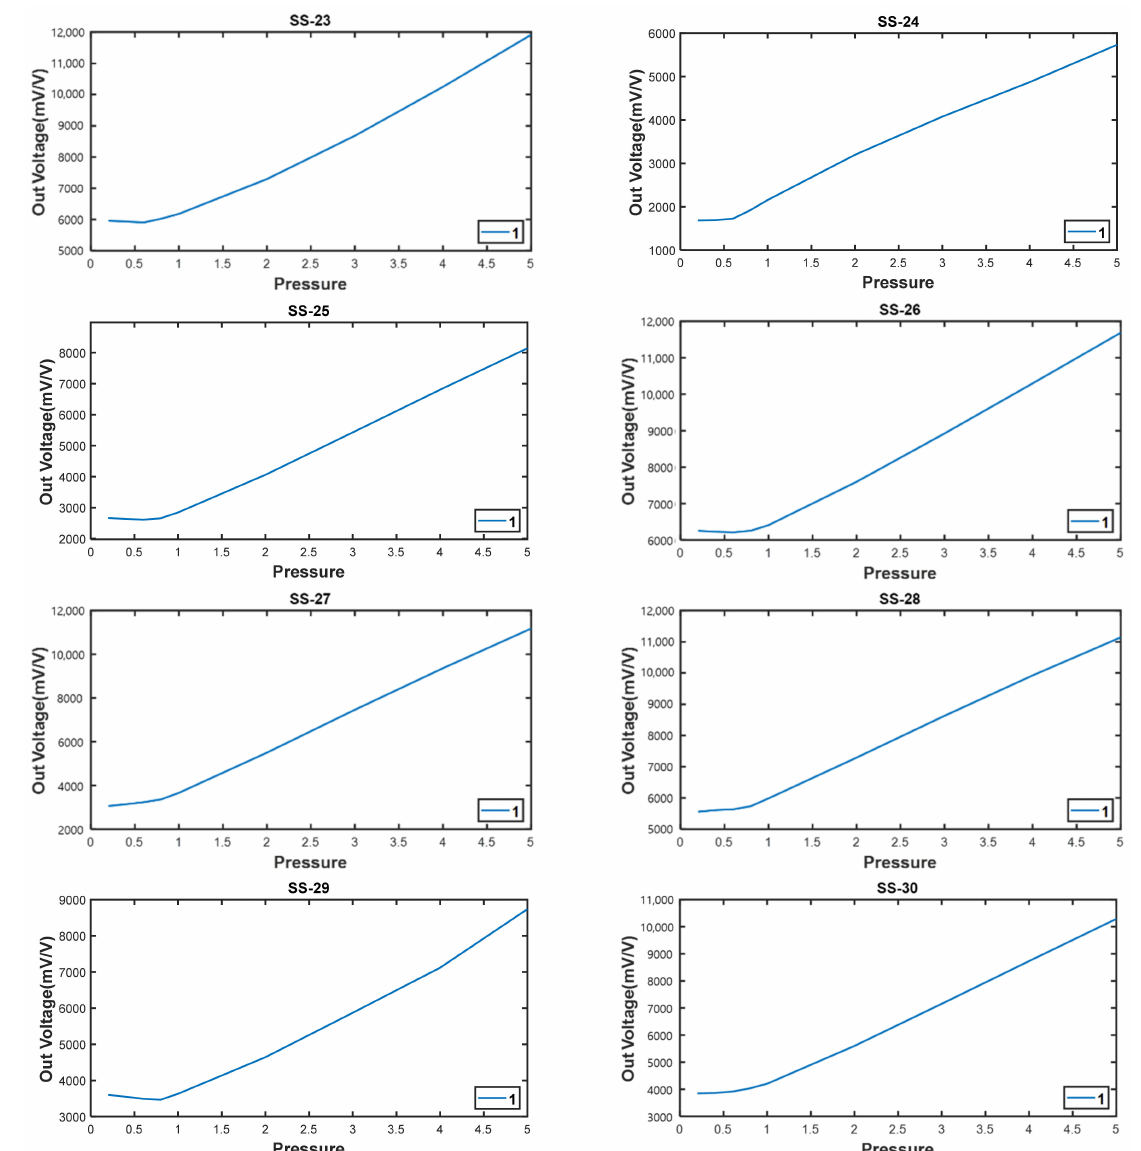
Figure 17. Graph of the data of the compressive load-cell experiment using